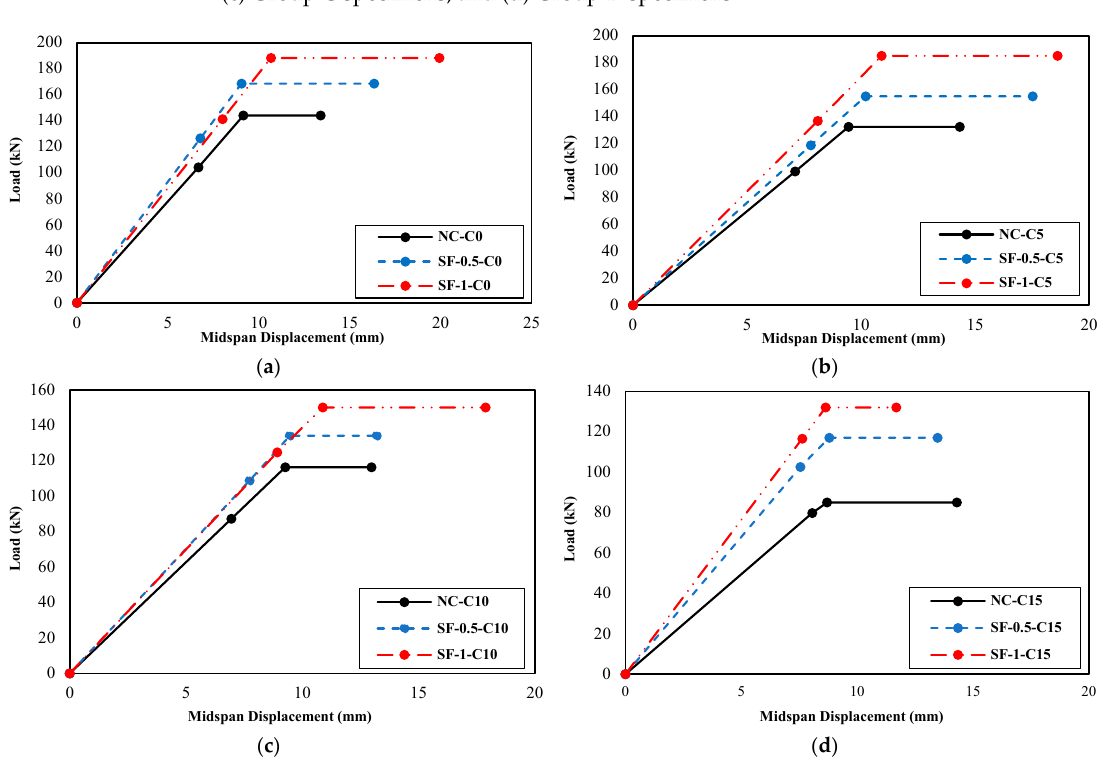
Figure 11. Load–midspan displacement diagrams: ( a ) Group A specimens, ( b ) Group B specimens, ( c ) Group C specimens, and ( d ) Group D specimens.